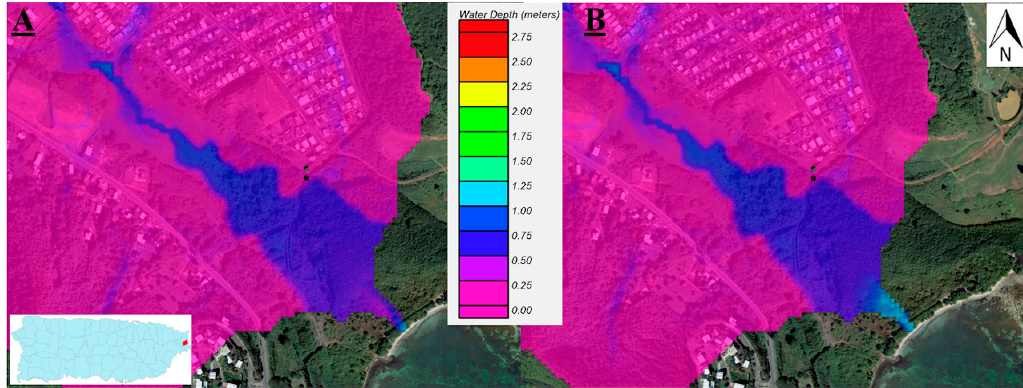
Figure 13. Maximum flood depth for the different flooding scenario at the QSN 1959 Creek watershed. ( A ) Without storm surge inland penetration; ( B ) Considering storm surge inland penetration. The color scale represents the water depth in meters, where the red color indicates the maximum value and the magenta color represents the minimum value.